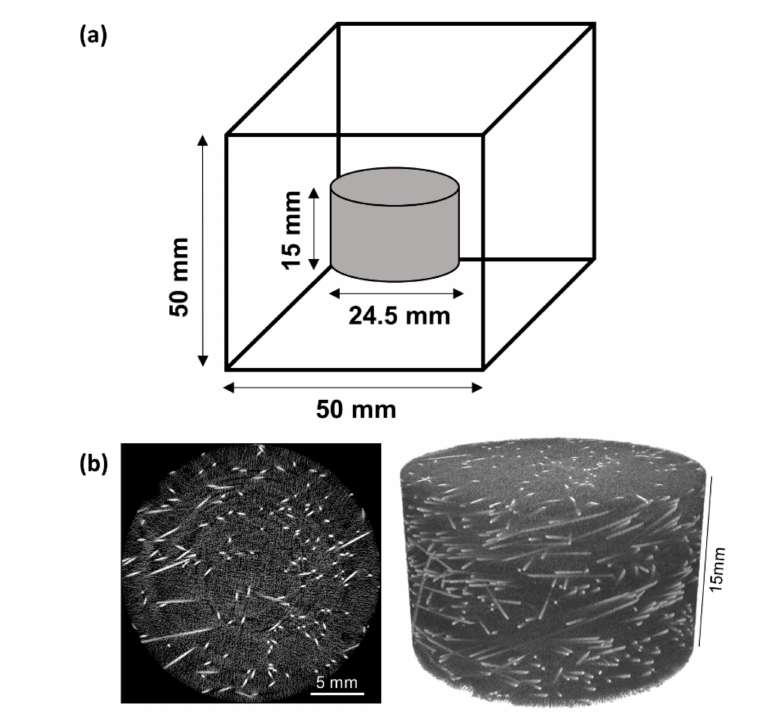
Figure 2. ( a ) Internal cylindrical structure obtained by micro-computed tomography (micro-CT). ( b ) Example slices (left) and three-dimensional (3D) re-conducted images (right) of specimens